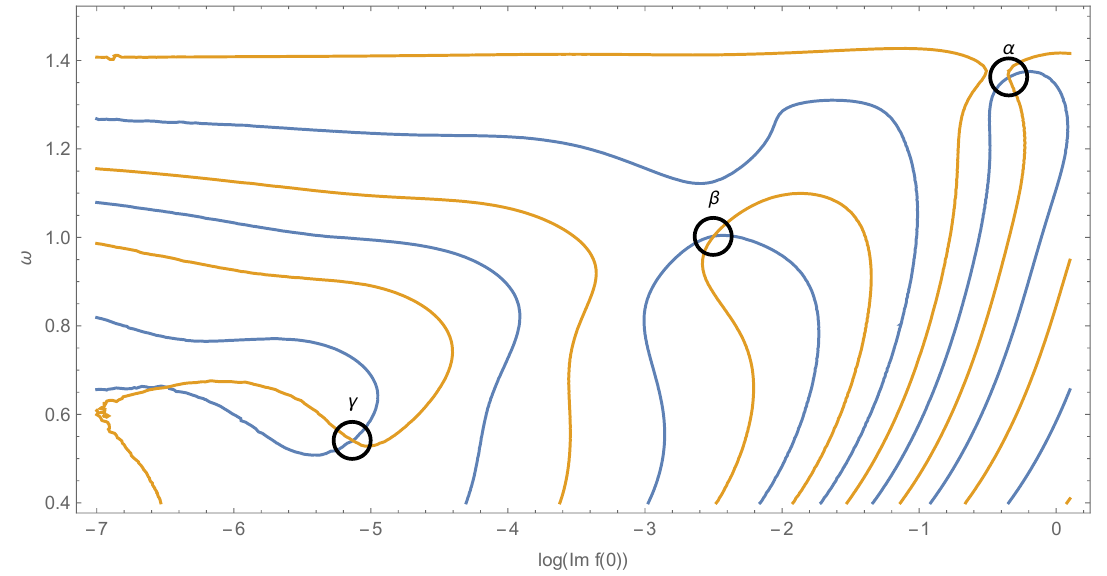
Figure 6 . Curves of vanishing real and imaginary parts of G ( !; Im f (0)) in the d = 4 hyperbolic case. Three solutions are easily spotted, which we call (cid:11) , (cid:12) , (cid:13) in order of decreasing Im f (0). A fourth intersection (cid:14) might lie around log Im f (0) (cid:24) (cid:0) 6 : 5, ! (cid:24) 0 : 65, but we don’t have enough control on the numerics to be